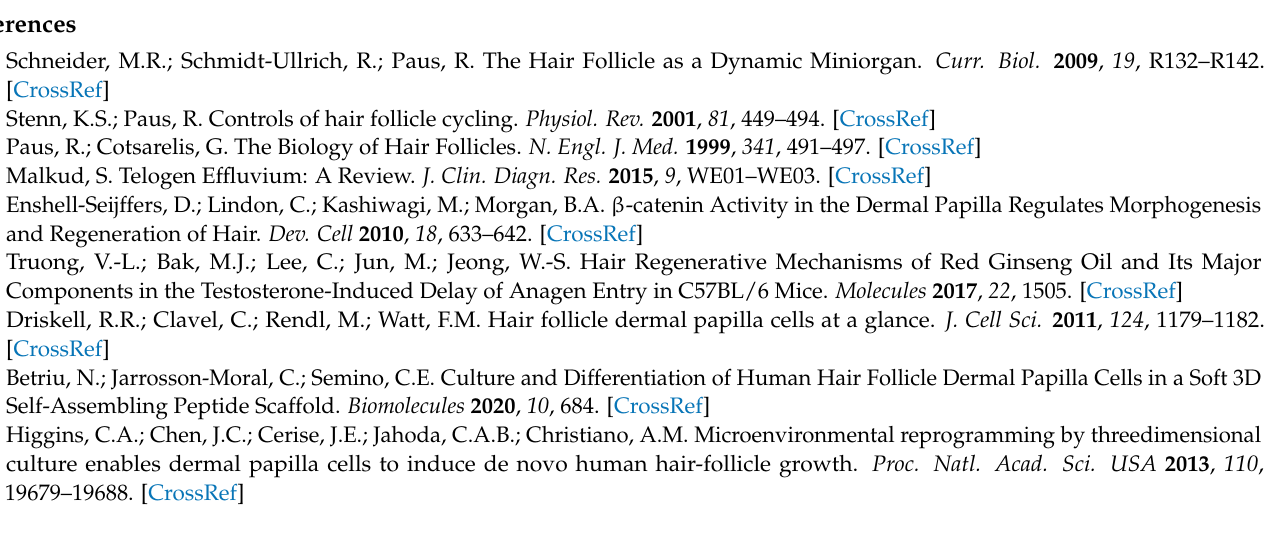
(vs. 2D control). Table S2: Top downregulated genes in 2D minoxidil-treated cells (vs. 2D control). Table S3: Top DEGs in 2D culture (TCQA vs. control). Table S4: Top upregulated hair growth-related genes 3D culture (TCQA vs. Control). Table S5: Top downregulated hair growth-related genes 3D culture (TCQA vs. control) figure preparation; A.K.O.: experimental design and execution, data analysis, manuscript and figure preparation; M.S.K.: experimental design and execution; F.F.: conception and design; H.I.: conception and design, financial support, final approval of manuscript. All authors have read and agreed to the published version of the